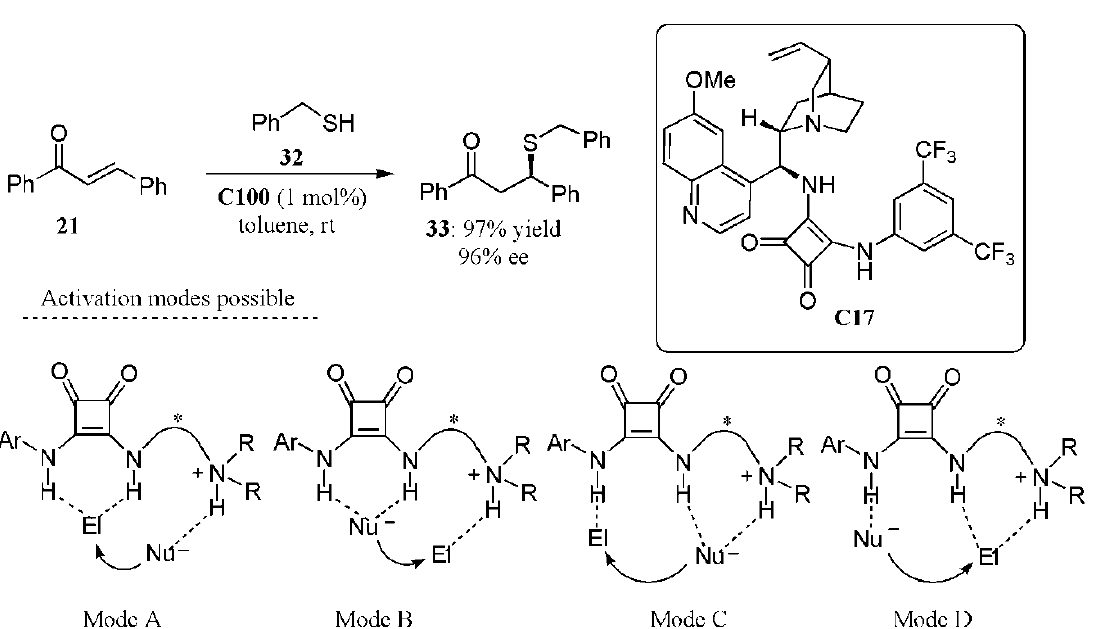
Figure 24. The sulfa-Michael addition reaction between benzyl thiol and trans -chalcone catalyzed by cinchona alkaloid- squaramide catalyst C17 and the four modes of bifunctional activation possible in the C–S bond-forming step [57].